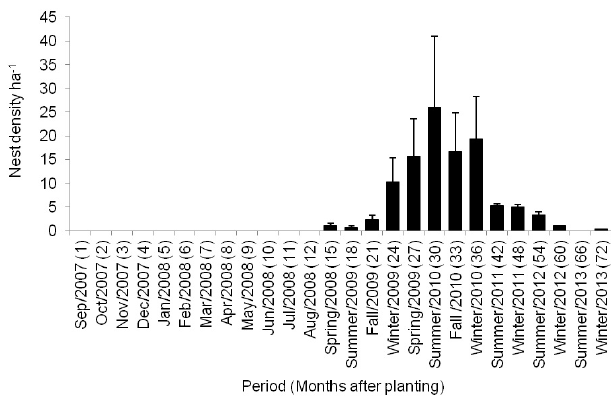
Fig 1. Density (mean ± standard deviation) of Acromyrmex crassispinus nests in a Pinus taeda plantation. São Mateus do Sul, PR, Brazil,